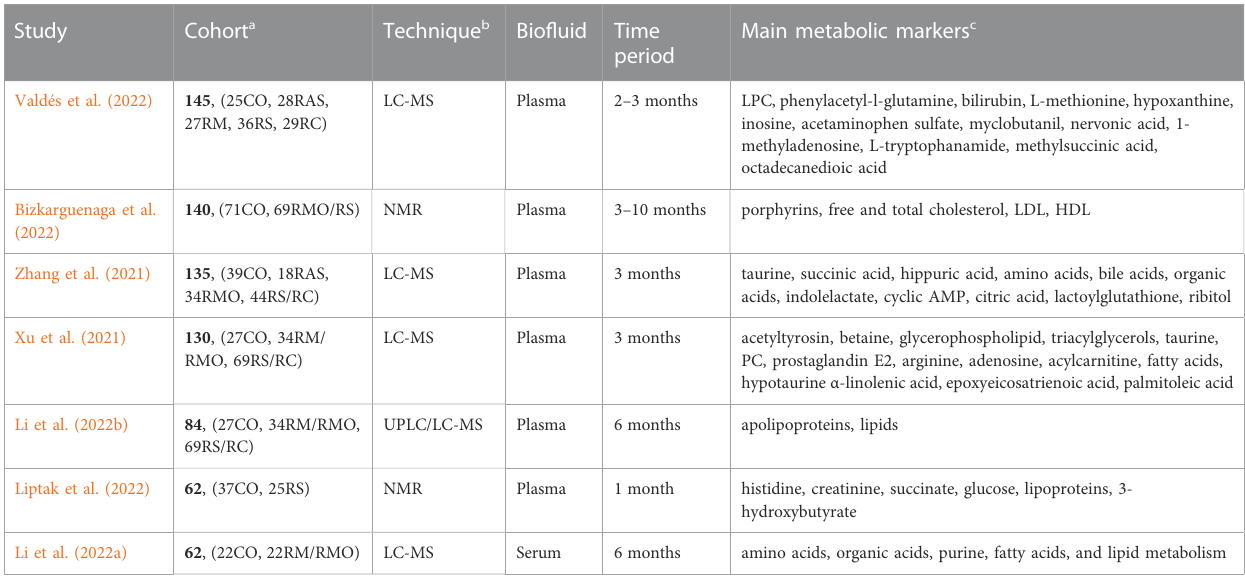
TABLE 3 COVID-19 metabolic recovery and natural history